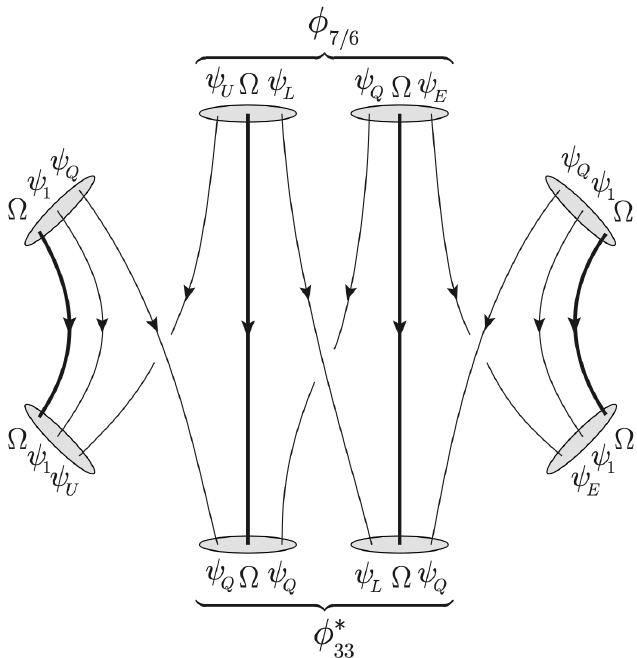
Figure 4 . Dimension-8 baryon-number violating operator (4.2) generated by SU(15) p dynamics at the scale Λ pre , through a nonplanar diagram. Each line corresponds to a certain preon exchanged between two prebaryons, which are represented by the gray ovals. The scalars φ di-prebaryons that acquire